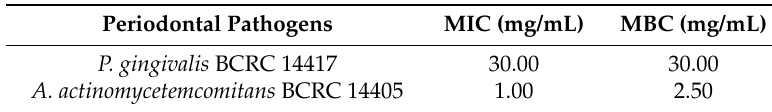
Table 3. Minimum inhibitory concentration (MIC) and minimum bactericidal concentration (MBC) of NTU101FM ethanol extract against periodontal pathogens.